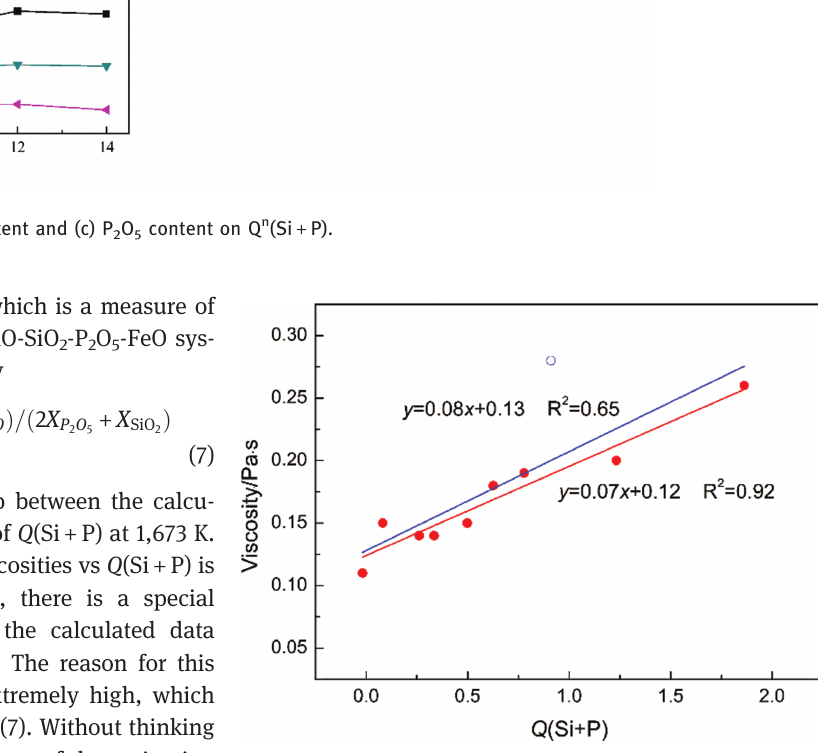
Figure 4: Relationship between the calculated viscosities and the parameter of Q (Si + P) at 1,673